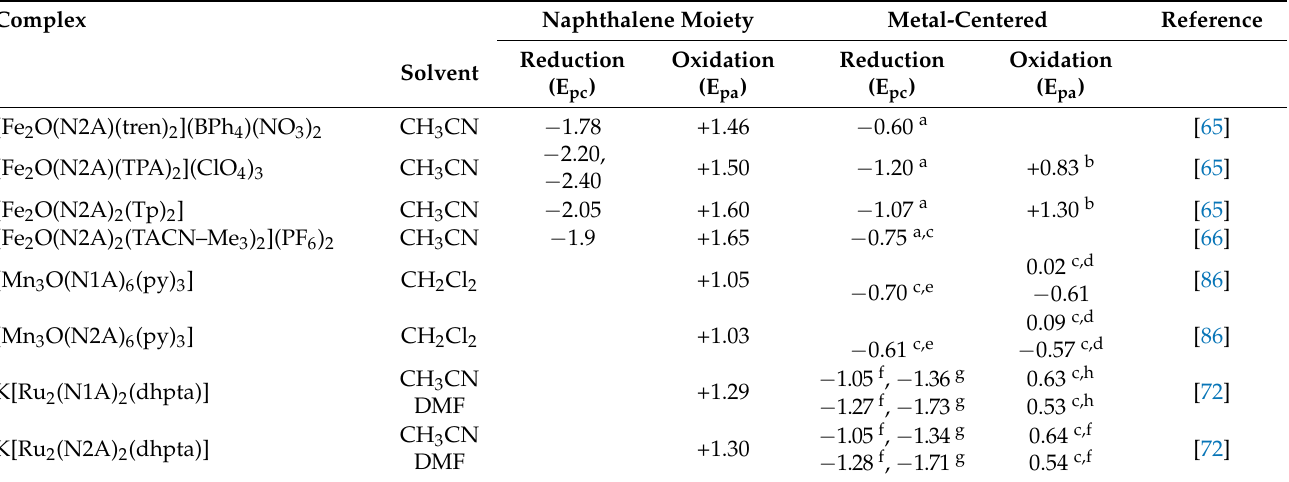
Redox potentials (in V) and process for complexes bearing 1–naphthylacetato or 2–naphthylacetato